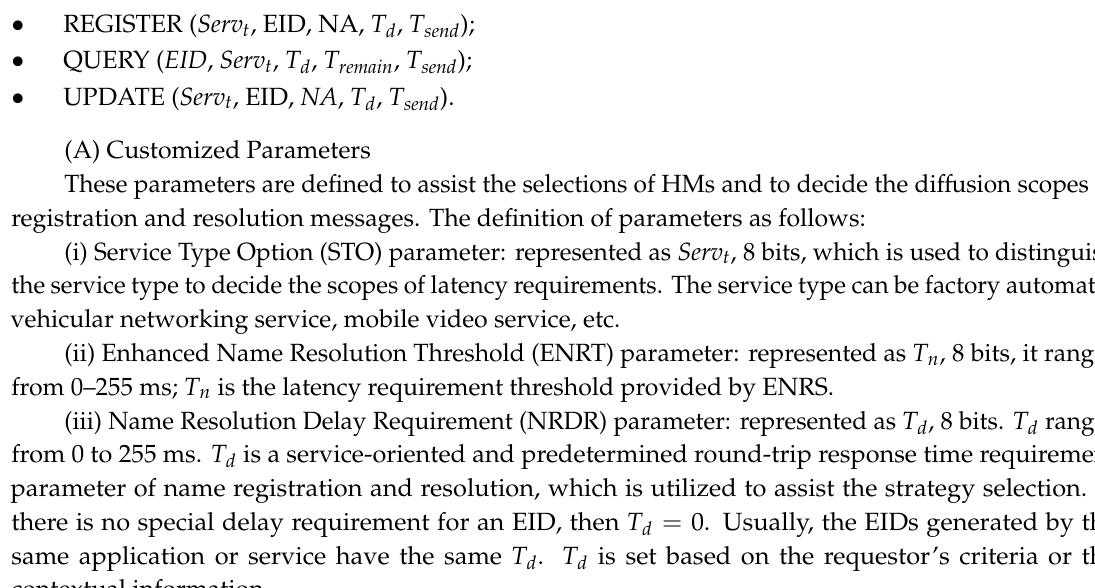
tree structure of hierarchical resolution nodes, as shown in Figure 3a.